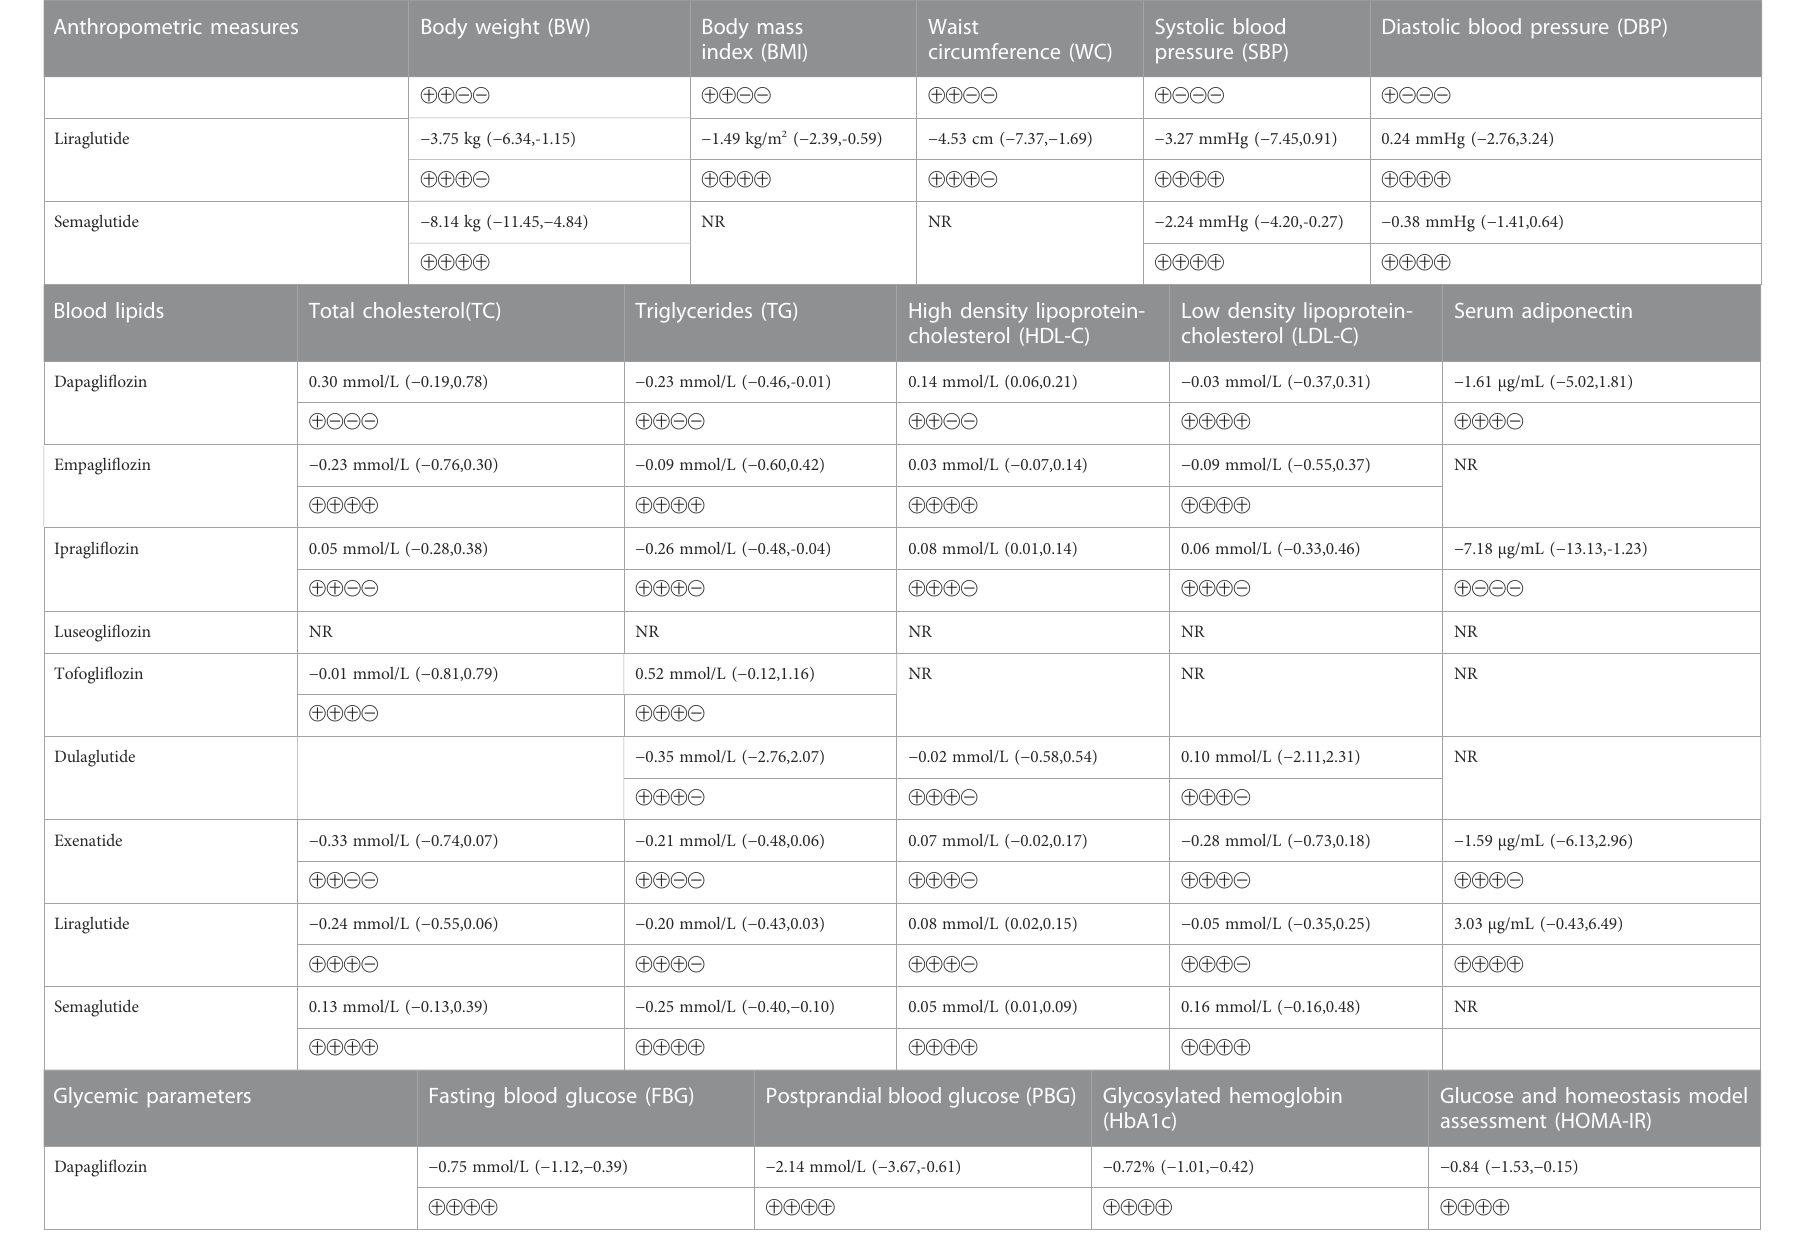
TABLE 1 ( Continued ) Summary of anticipated absolute differences in outcomes comparing sodium-glucose cotransporter-2 inhibitor and glucagon-like peptide-1 receptor agonist treatment with placebo